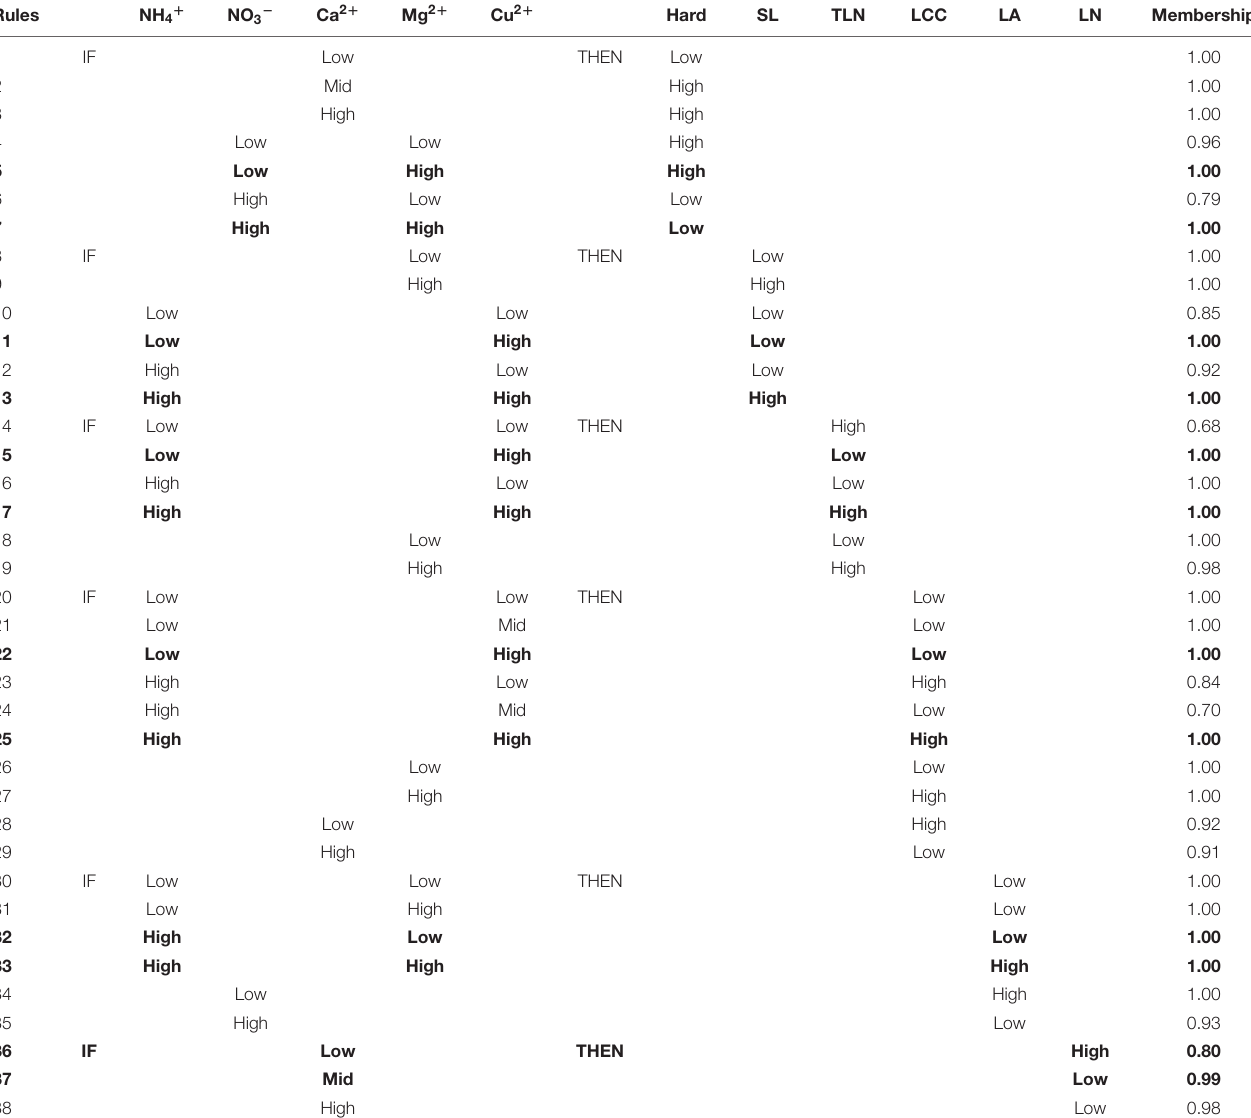
TABLE 5 | Rules generated by neuro-fuzzy logic showing the best combination of inputs to obtain the highest and lowest physiological responses with their membership degree for each output.